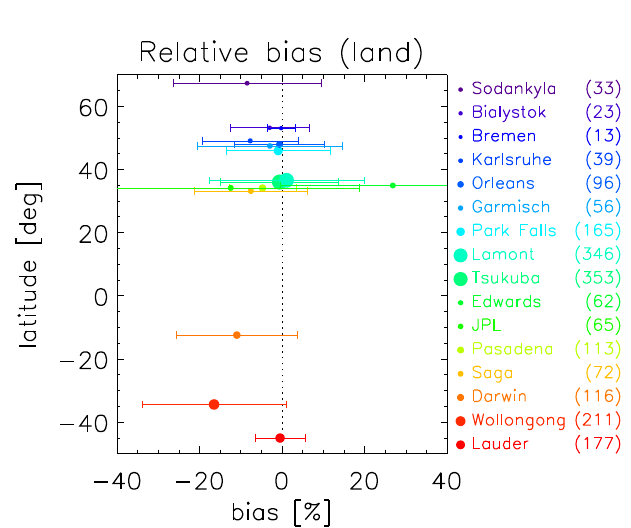
Figure 3. Correction of Figure 3 in [1]. Mean relative bias (filled circles) and associated standard deviation (“error bars” representing ± σ ) as a function of the latitude of the TCCON sites, for coincidence criteria of ± 30 min and ± 1 ◦ in latitude and longitude. The dataset names and corresponding number of coincidences are shown on the right-hand side, color-coded from purple to red in order of decreasing latitude from the northernmost site (Sodankylä, 67.4 ◦ N) to the southernmost station (Lauder, 45.0 ◦ S). The size of the symbols is proportional to the number of coincidences at each